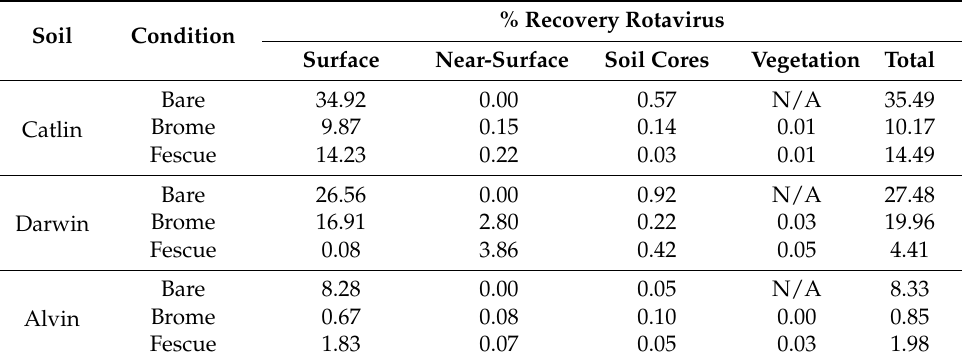
Table 1. Summary of partitioning of infective rotavirus particles between surface runoff, near-surface runoff, soil core extractions, and vegetation extractions. All values are percentages (%) of the amount recovered relative to the amount applied.